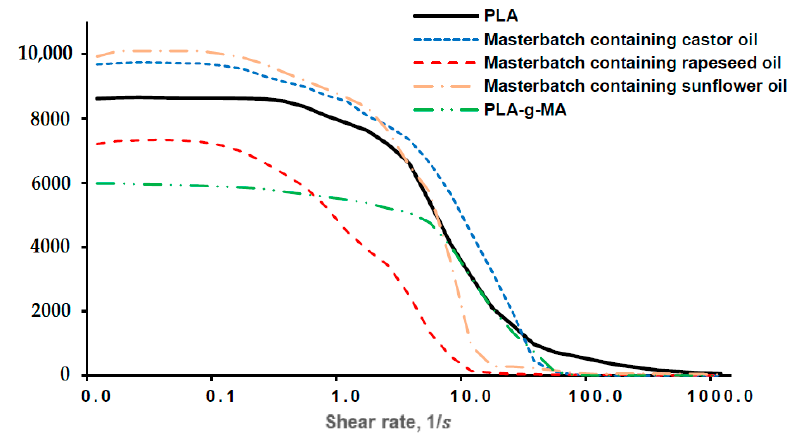
Figure 5. Rheological behaviour of PLA granulates and masterbatches in the range of 1–1000 1 (170 ◦